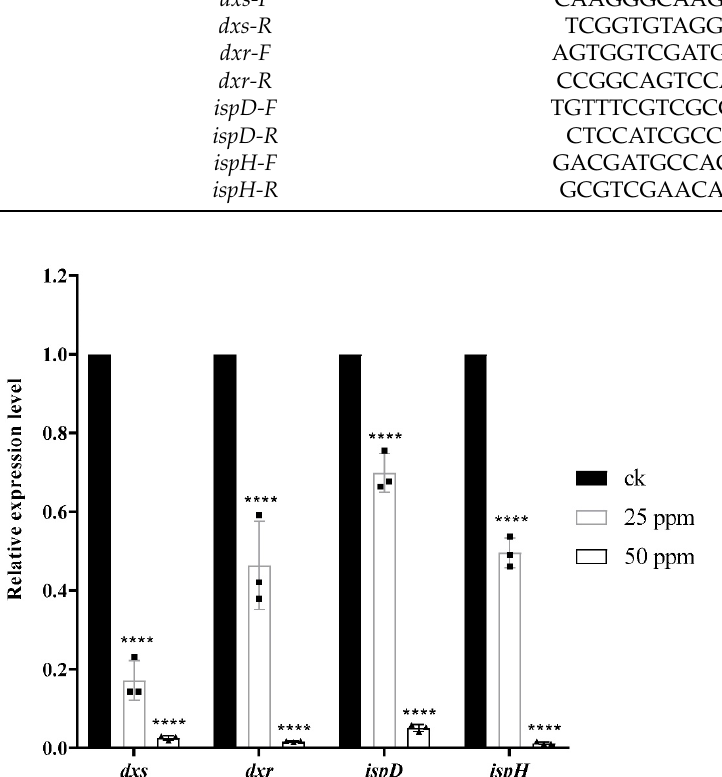
Figure 5 . Analysis of the relative expression of related genes ( dxs , dxr , ispD , ispH ) through RT-qPCR (2 −∆∆ Ct ), **** p < 0.0001, One-way ANOVA followed by Dunnett’s multiple comparisons test was per- formed using GraphPad